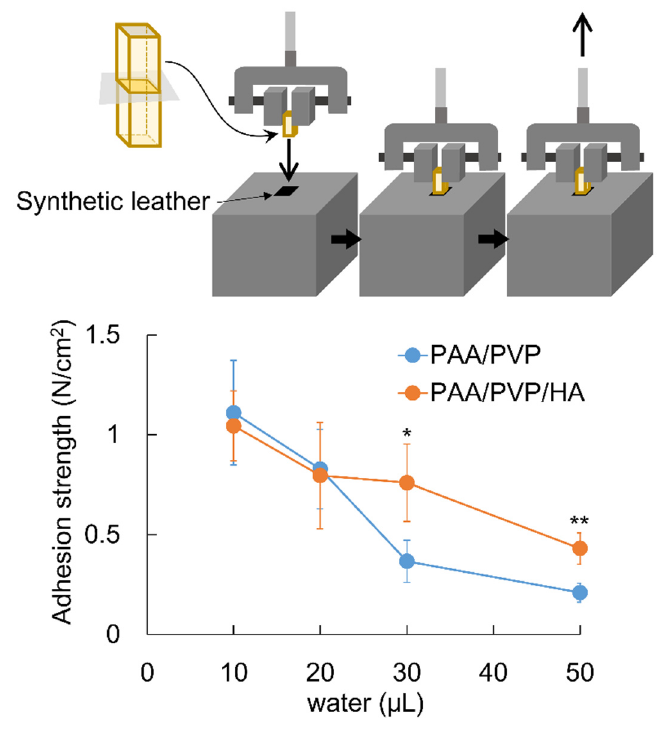
Figure 5. Pull-off adhesion strength of PAA/PVP complexes with or without HA with a synthetic leather piece wetted by various amount of water. Significance in difference between two groups was tested using Student’s t -test. (mean ± SD, * p < 0.05, ** p < 0.01).